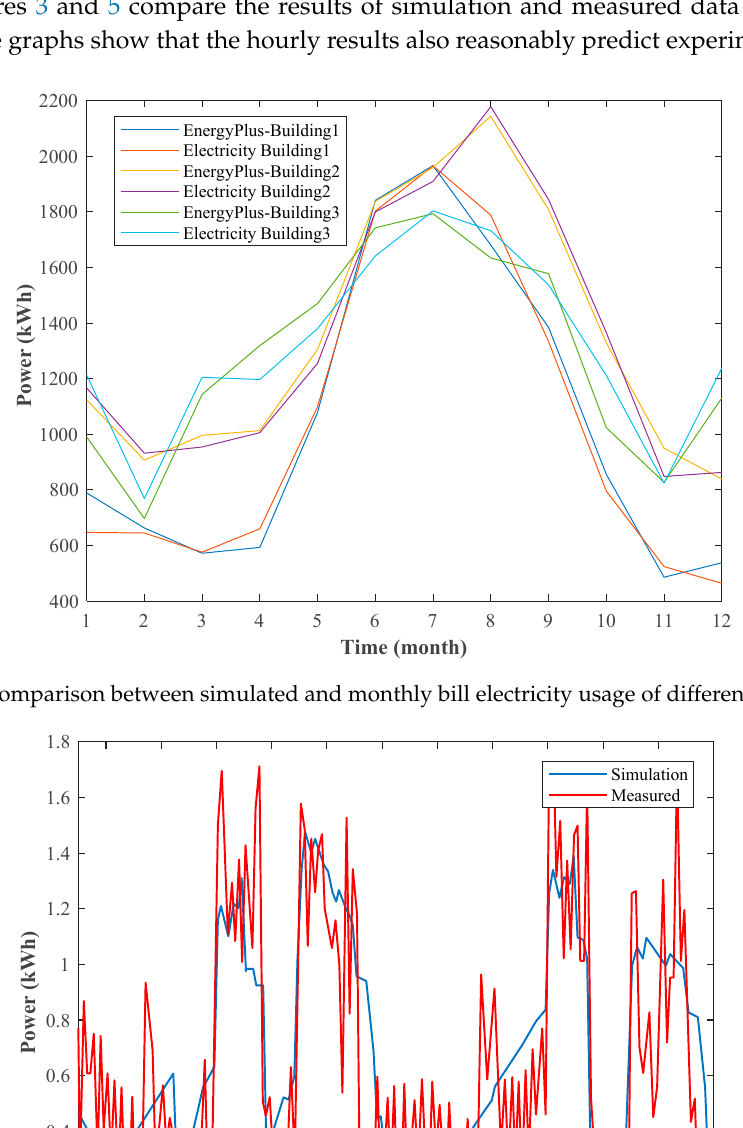
Figure 4. Simulated and measured hourly electricity usage of building 2.